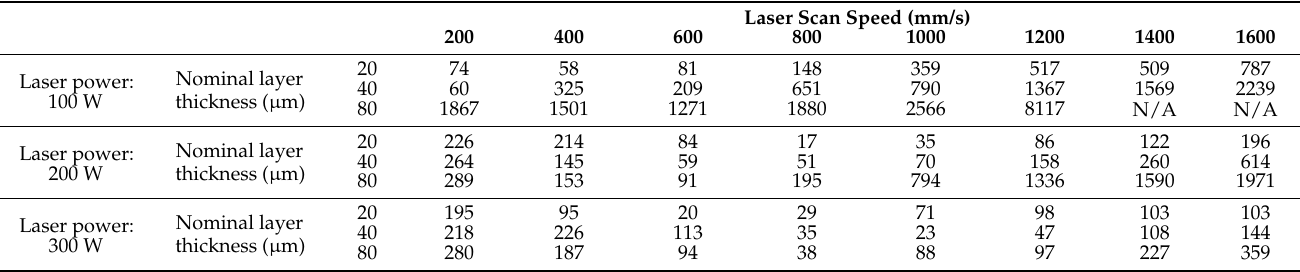
Table A1. Largest flaw size ( µ m) identified across the process space. “N/A” indicates manufacturing could not be completed due to extreme processing